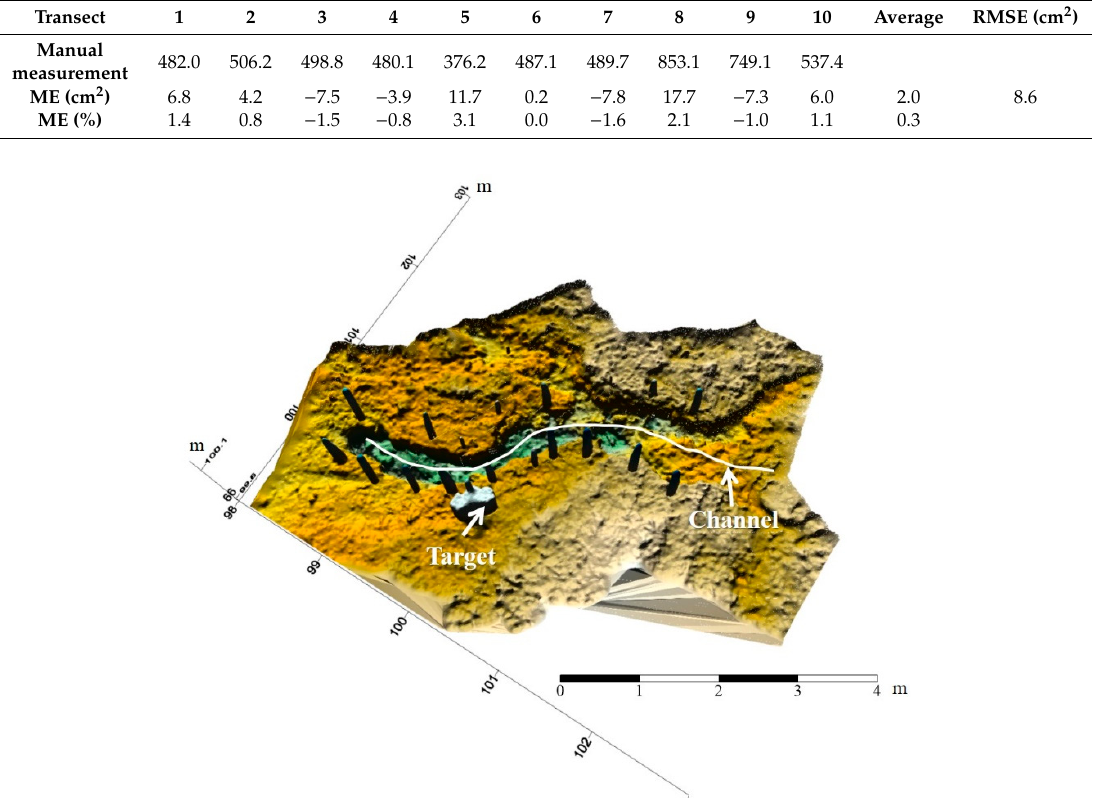
Table 5. Error and RMSE of cross-section area (cm 2 ) of selected transects derived from the CGC-CRP method for the water-induced channel on the soil surface.